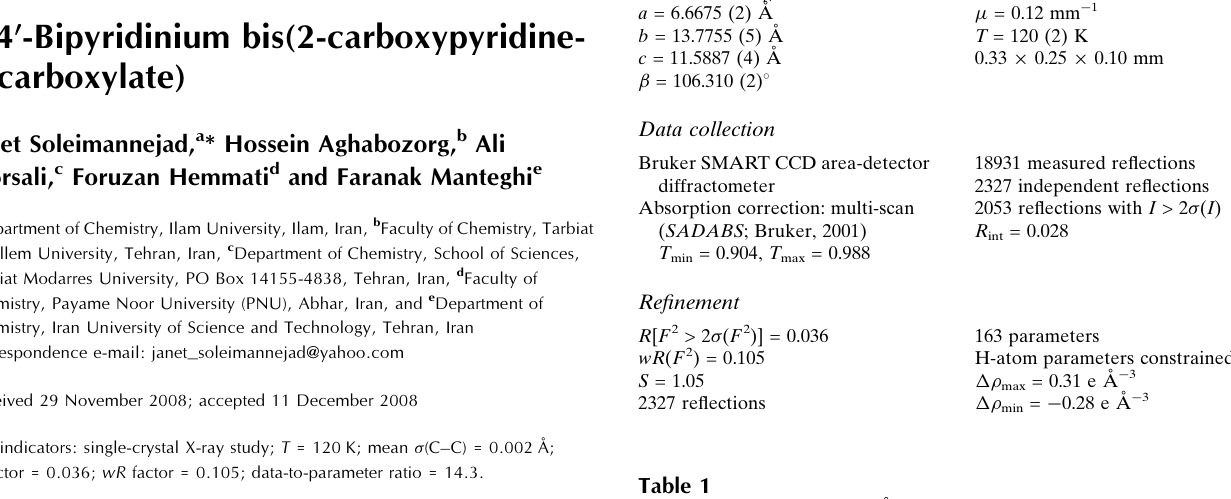
Hydrogen-bond geometry (A˚ , (cid:3)